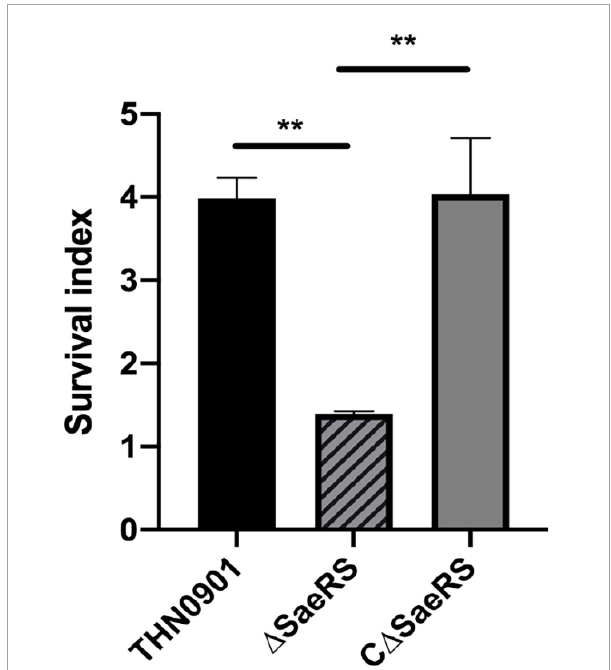
FIGURE6 Whole blood-killing assay. The survival index was calculated. Each experiment was performed in triplicate, and data were presented as mean ± standard deviation (SD), *: 0.01 < P < 0.05, **: P < 0.01.